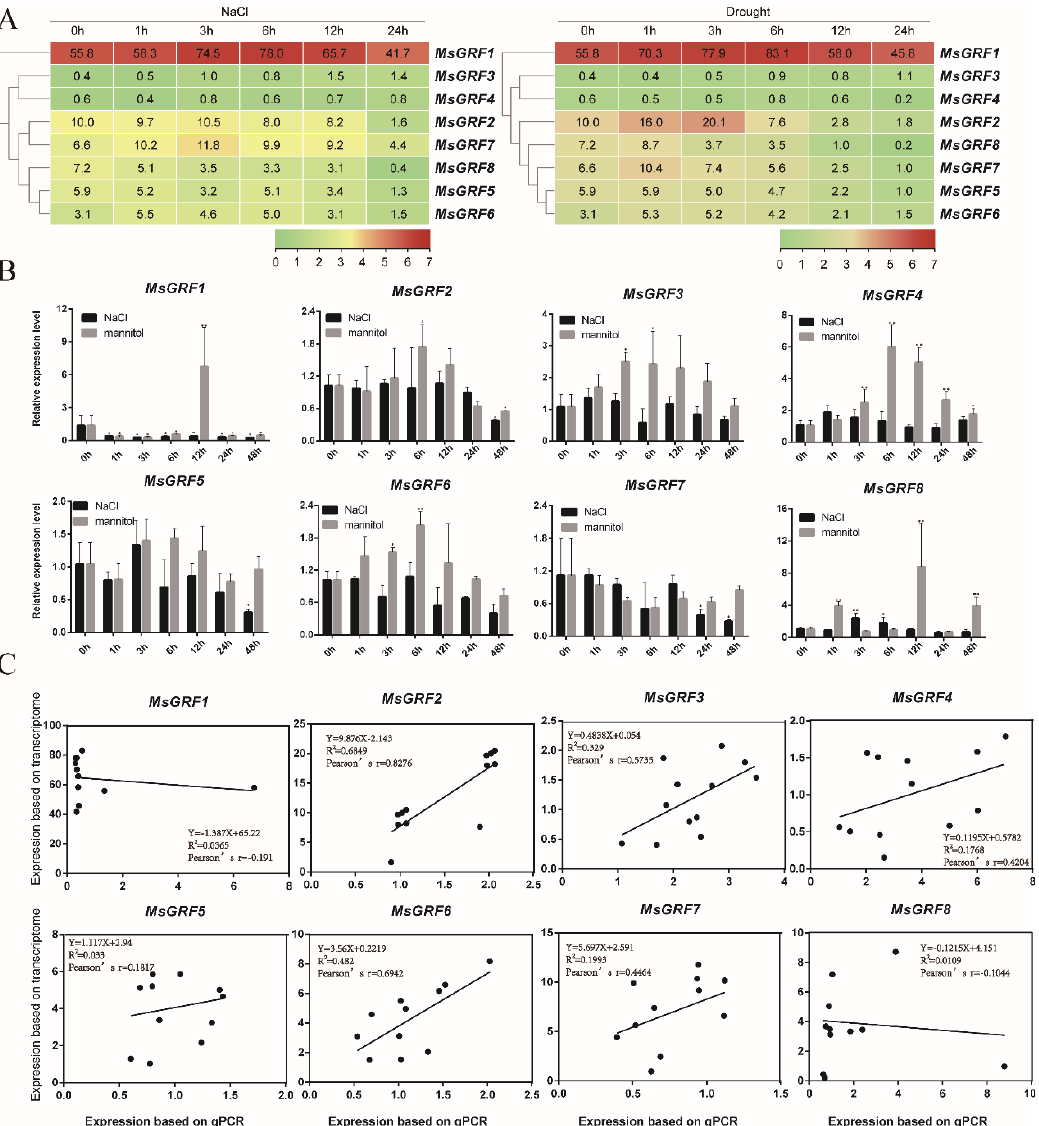
Figure 8. Expression profiles of MsGRF genes under NaCl and mannitol stress. ( A ) MsGRF genes expression in roots under NaCl treatment at different time points; in root under drought treatment at different time points. ( B ) qPCR analysis on the expression level of MsGRF genes treated with 300 mM NaCl and 15% mannitol at 0 h, 1 h, 3 h, 6 h, 12 h, 24 h, and 48 h. Data are the average of three independent biological samples ± SE, and vertical bars indicate standard deviation. ** indicates p < 0.01, and * for p < 0.05. ( C ) Correlation analysis of qPCR and transcriptome data for MsGRF genes. Pearson’s r indicates the Pearson correlation coefficient.